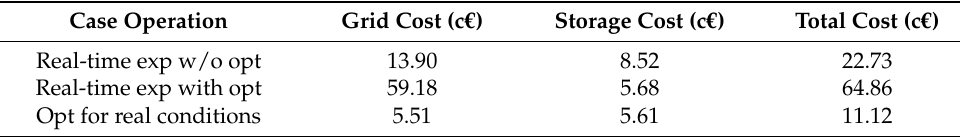
Table 4. Energy system cost—experimental test 1.